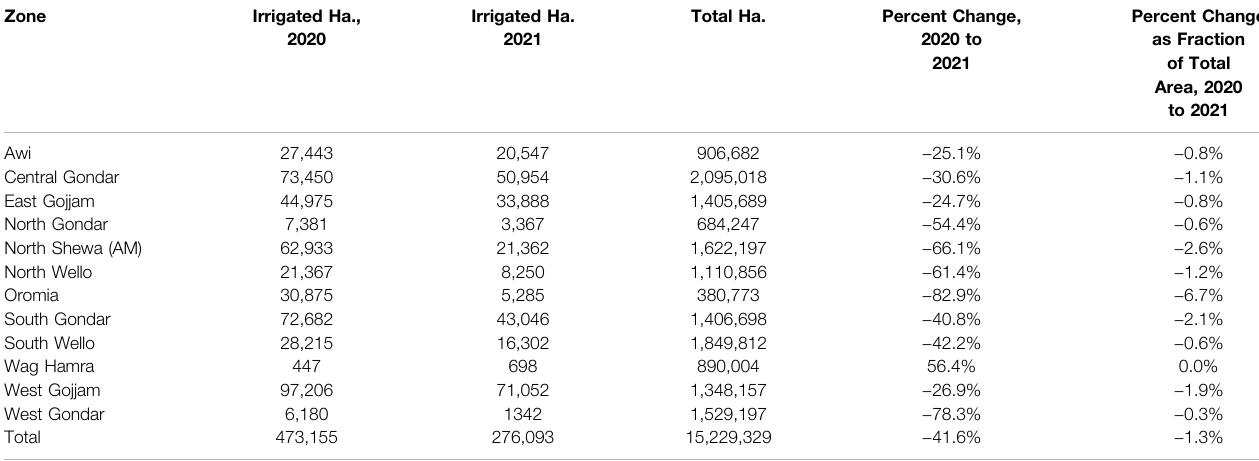
TABLE 3 | Predicted irrigated area statistics in Amhara for 2020 and 2021, organized by